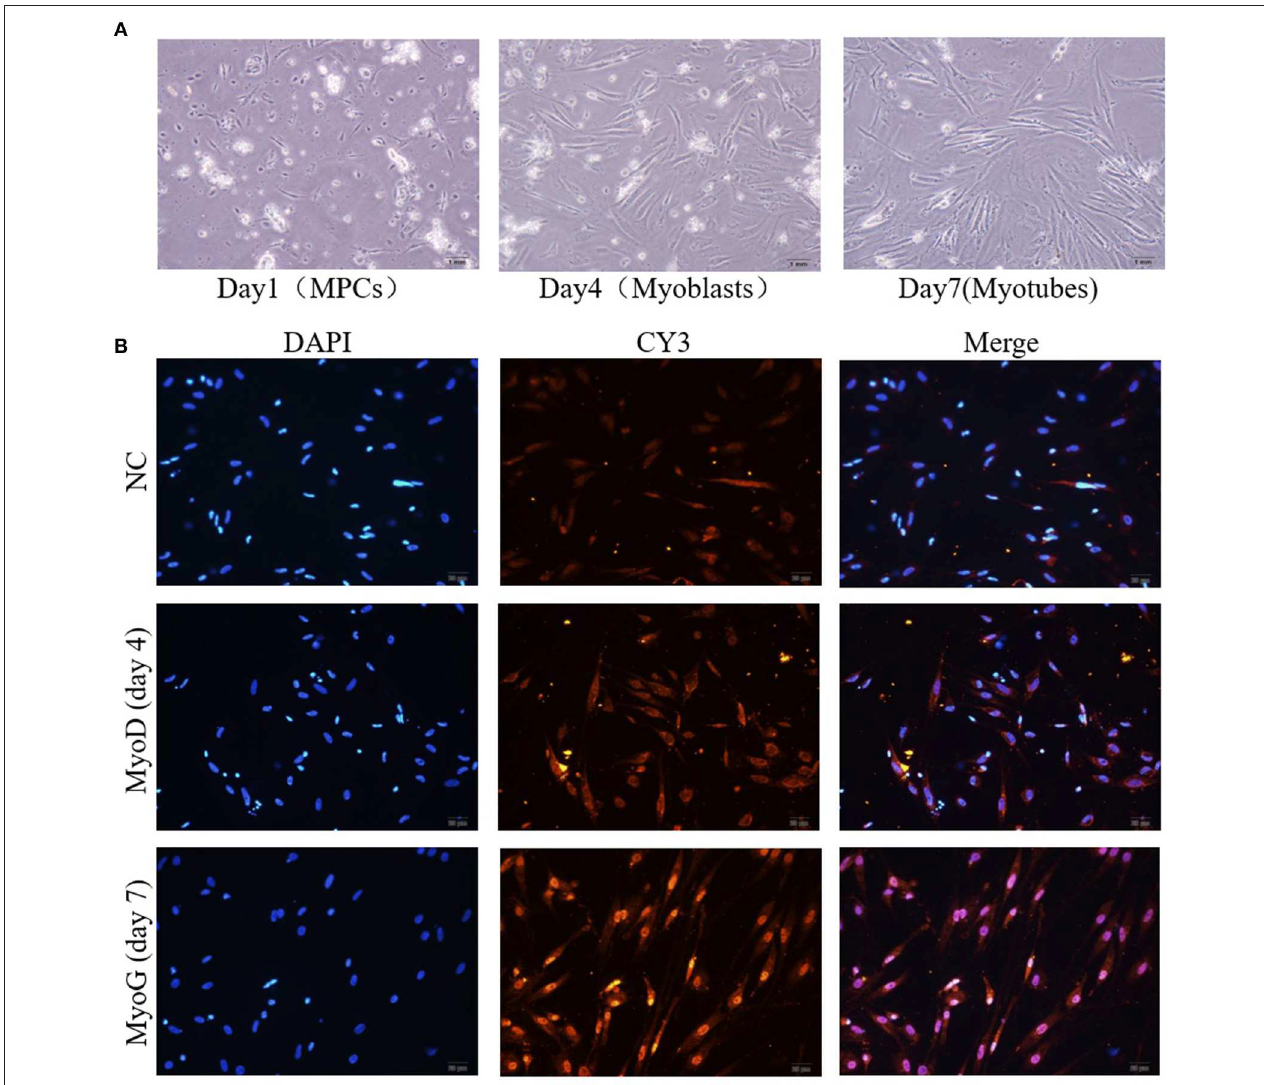
FIGURE 5 | Isolation and identification of primary muscle cells from tilapia. (A) The culture of myosatellite cells (day 1), myoblasts (day 4), and myotubes (day 7). (B) Immunocytochemical staining of myoblasts (day 4) and myotubes (day